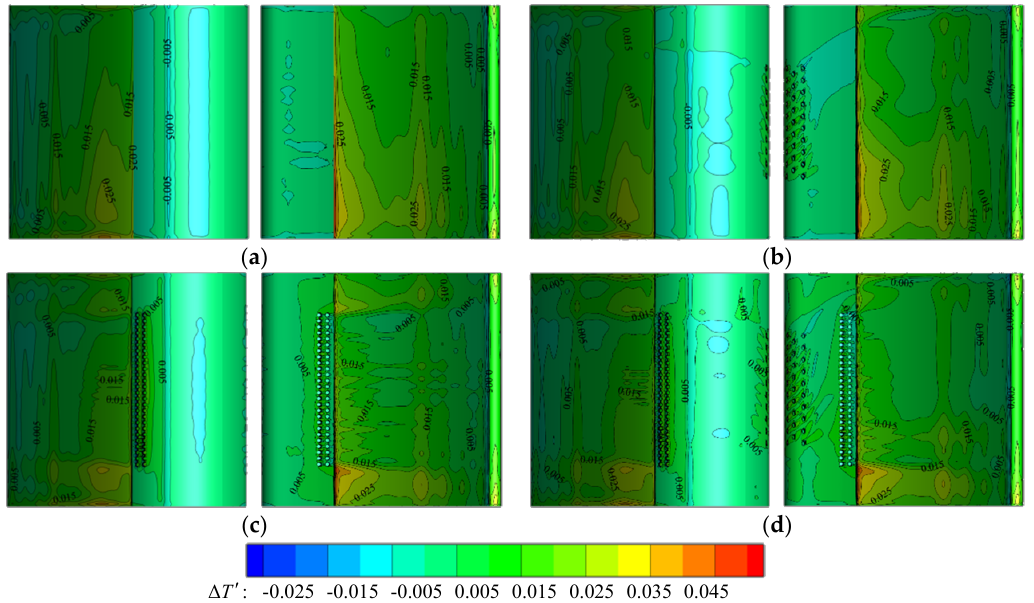
Figure 8. Surface temperature comparisons for different cases. ( a ) coated vane without film, ( b ) coated vane with LE film, ( c ) coated vane with downstream film, ( d ) coated vane with LE and downstream film.